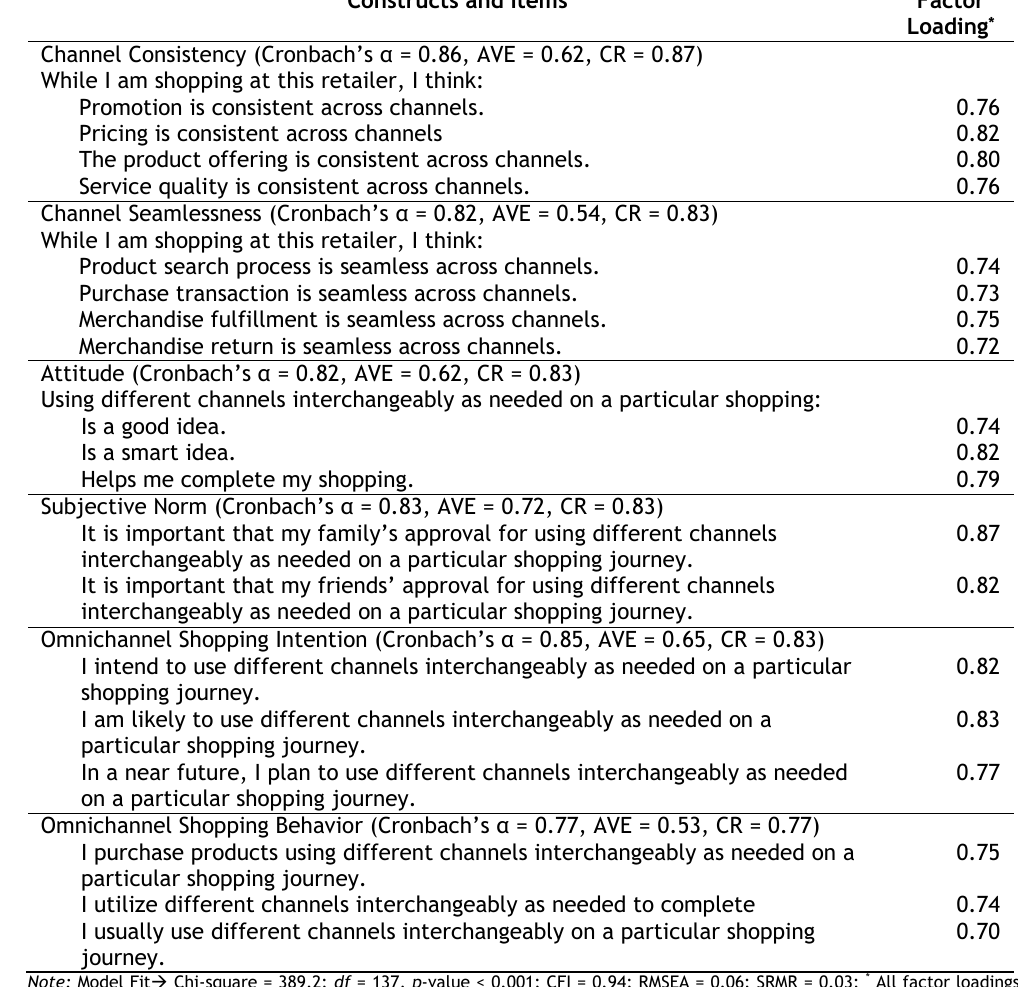
Table 1. Measurement model and statistics Constructs and Items